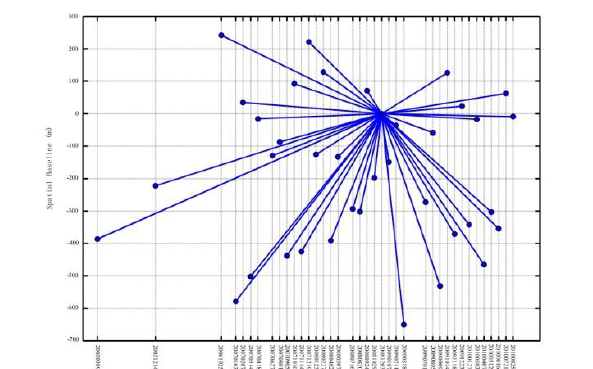
Figure 2. Spatial-temporal baseline of Envisat ASAR